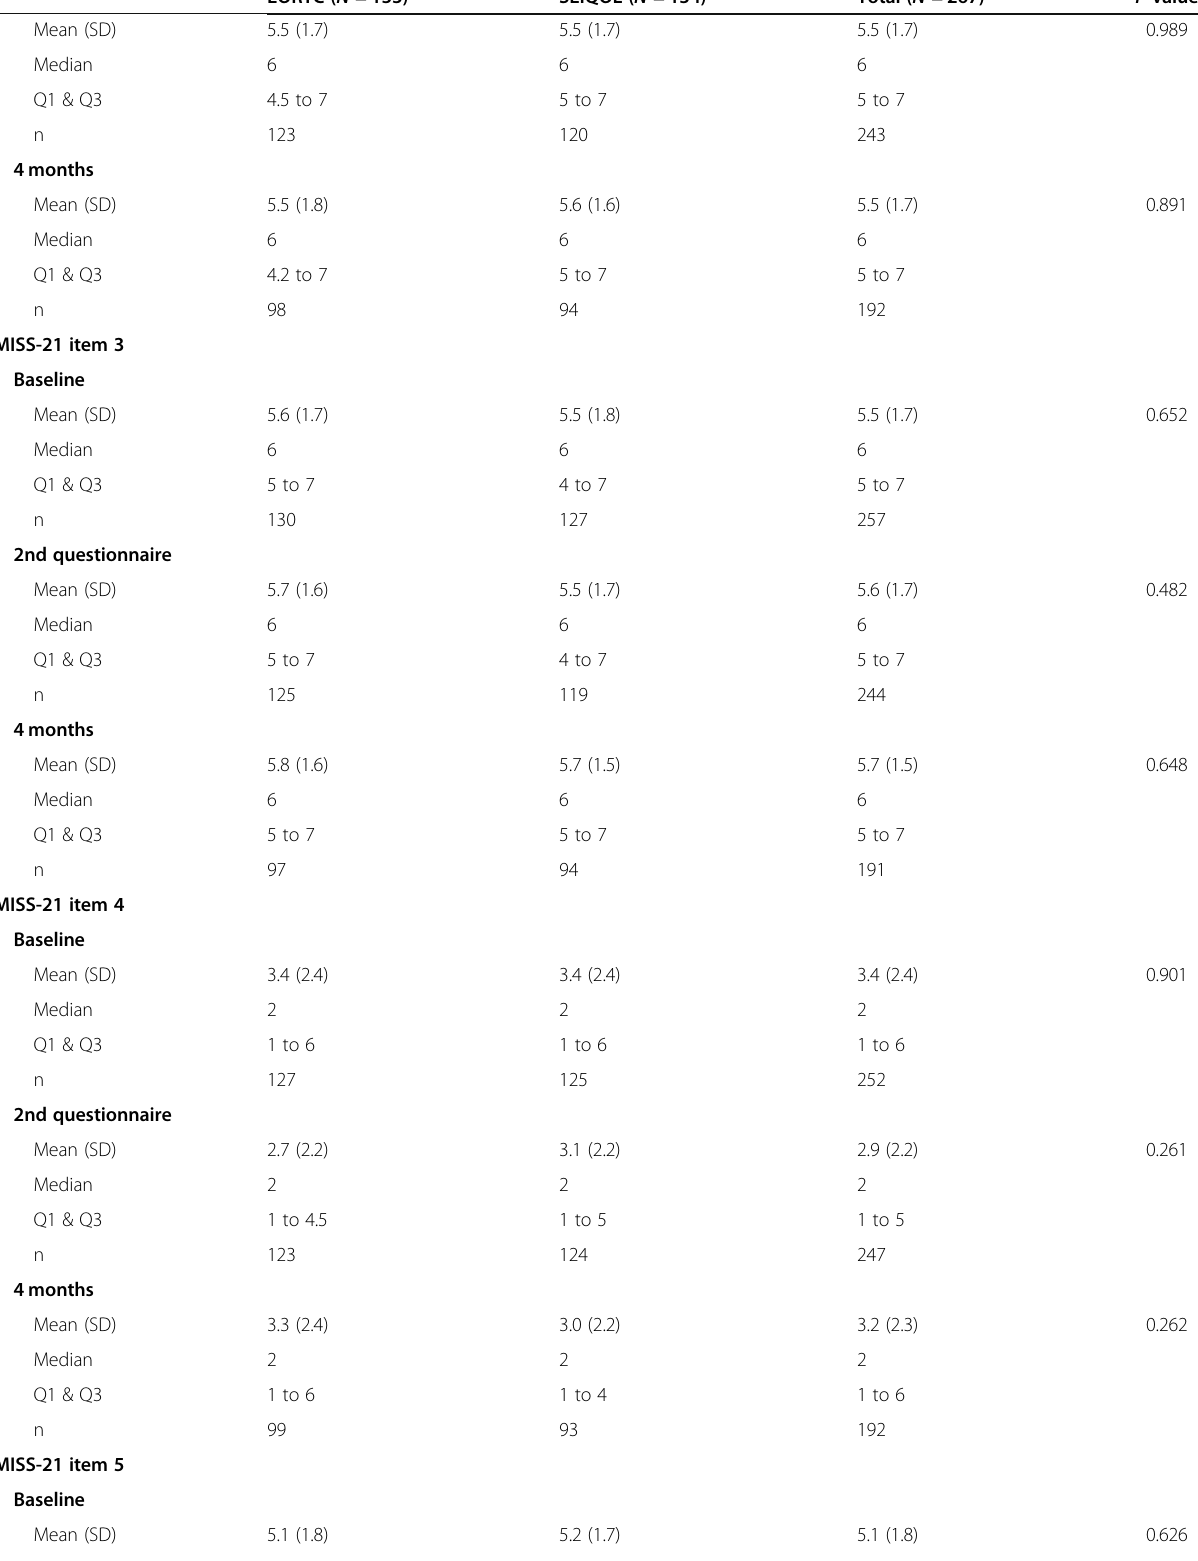
Table 2 Outcomes a over time for analyzed patients